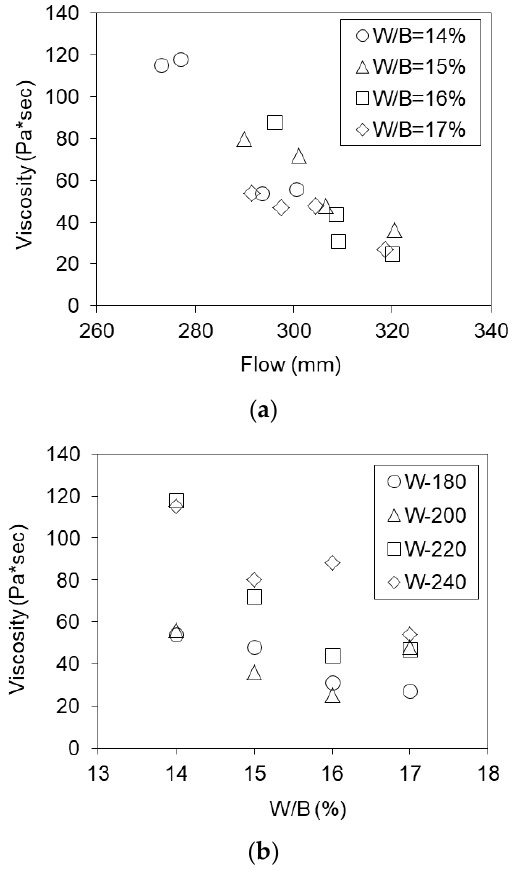
Figure 11. Mortar viscosity. ( a ) Mortar flow—viscosity. ( b ) W/B—viscosity.